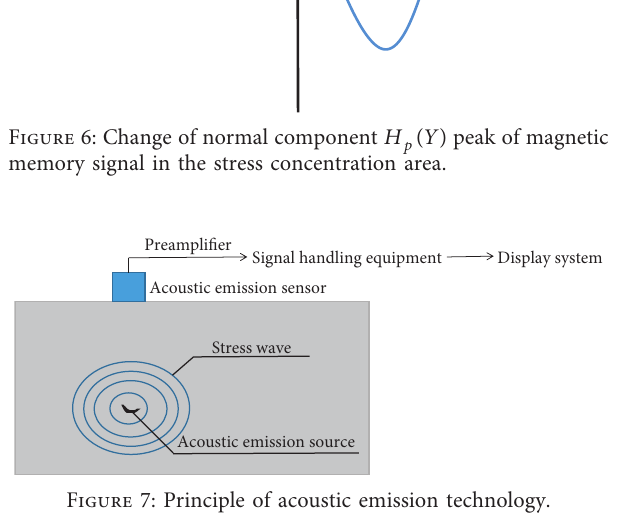
Figure 7: Principle of acoustic emission